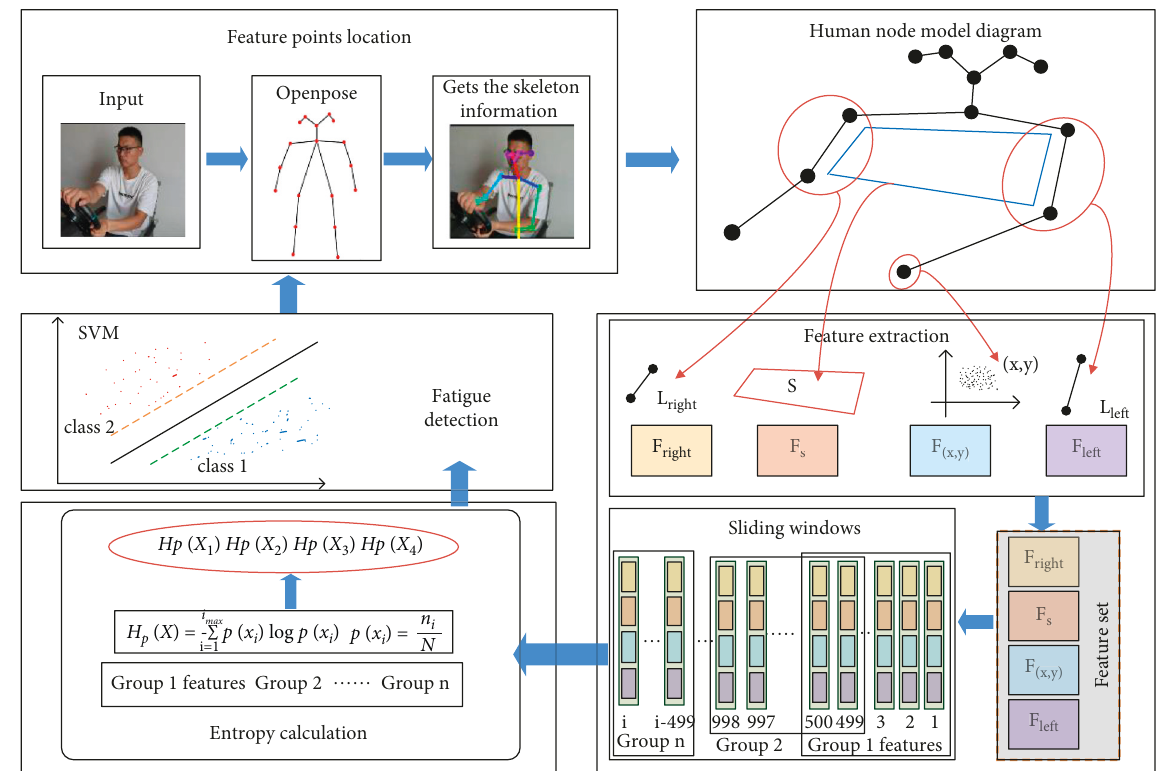
Figure 1: There are four main steps. First, the OpenPose algorithm is applied to extract skeleton information and detect the key points. Then, four types of fatigue features ( F right , F s , F ( x , y ) , and F left ) are extracted using the key points. Next, information entropy theory [20] is employed to calculate the entropy value of fatigue features over a specified period. Finally, an SVM classifier is proposed to obtain the fatigue